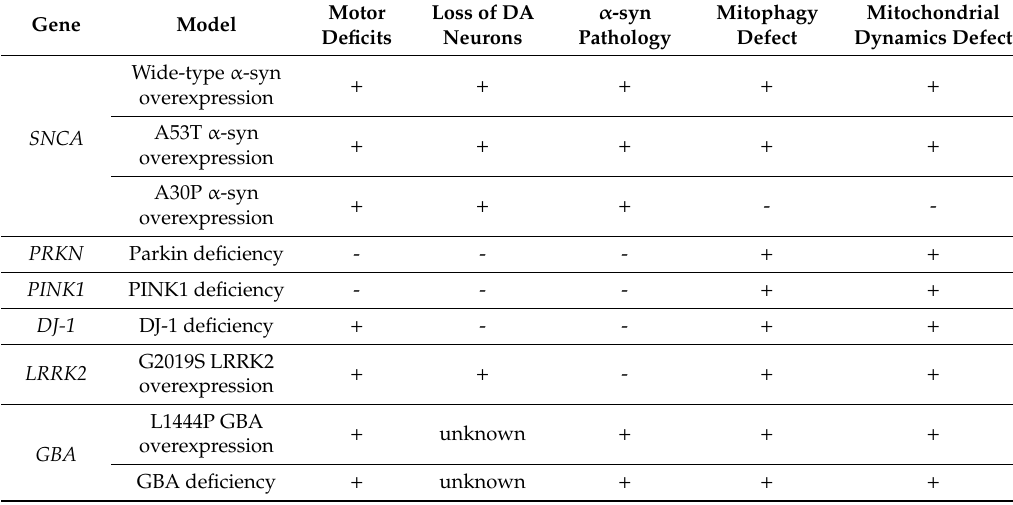
Table 2. Overview of mitophagy or mitochondrial dynamics deficits in PD transgenic models. Overexpression or deficiency of PD-related genes, including SNCA, PRKN, PINK1, DJ-1, LRRK2, and GBA , contributes to mitophagy or defects in mitochondrial dynamics. α -syn, α -synuclein; DA, dopaminergic; GBA, glucocerebrosidase; LRRK2, Leucine-rich repeat kinase 2; PINK1,